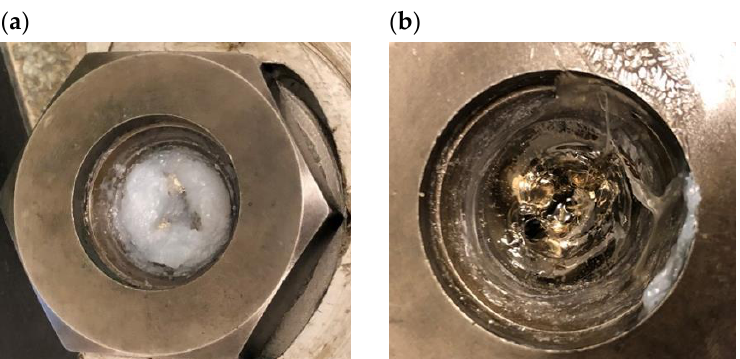
Figure 7. Base grease in the lower handle of the 4-ball tester: ( a ) before and ( b ) after the tribological test-node load 100 kgf for 1 min.